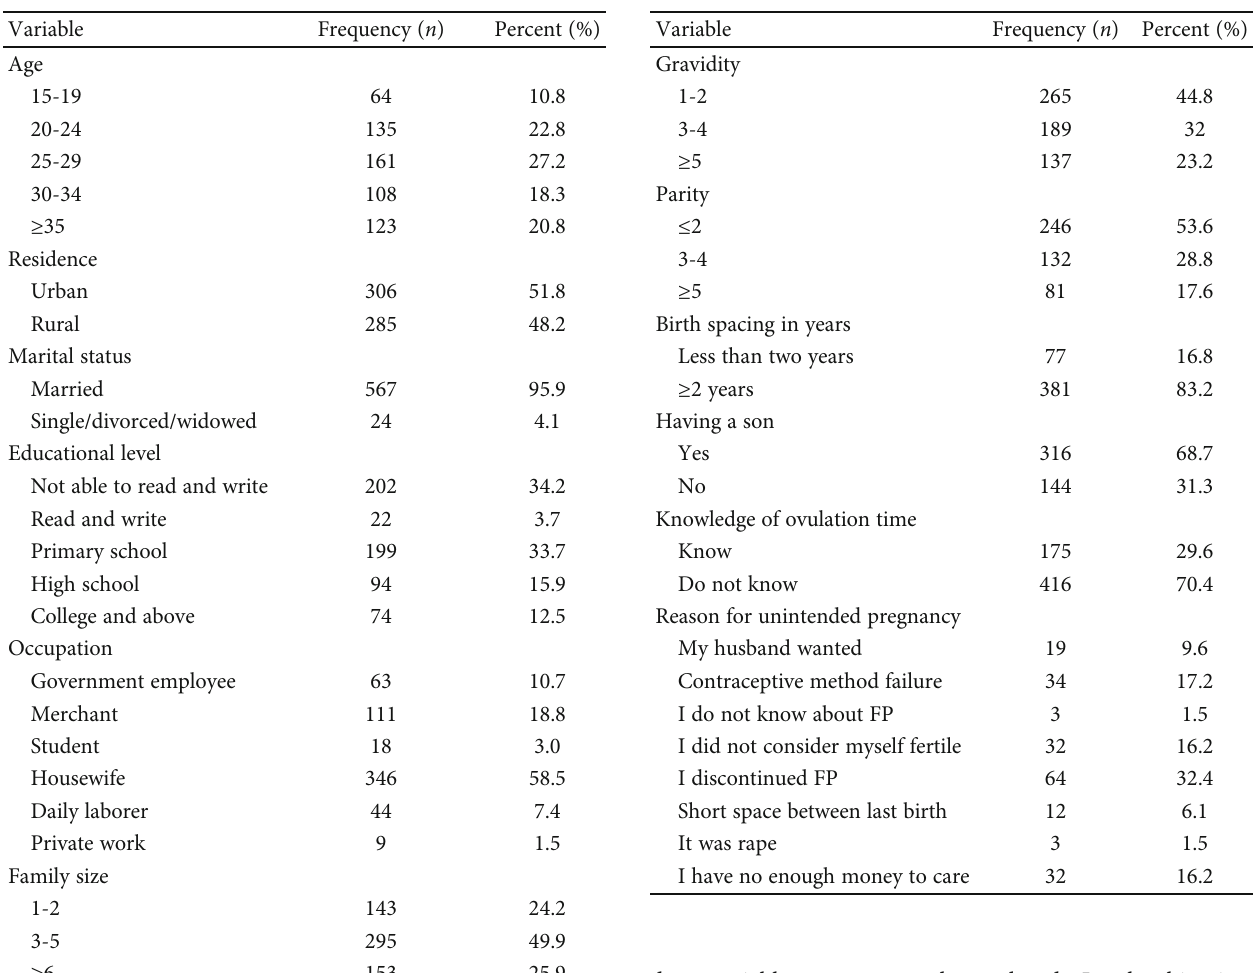
Table 1: Sociodemographic characteristics of respondents among pregnant women attending ANC at Bako Tibe district at public health centers and hospital, 2019 ( n = 591 ).